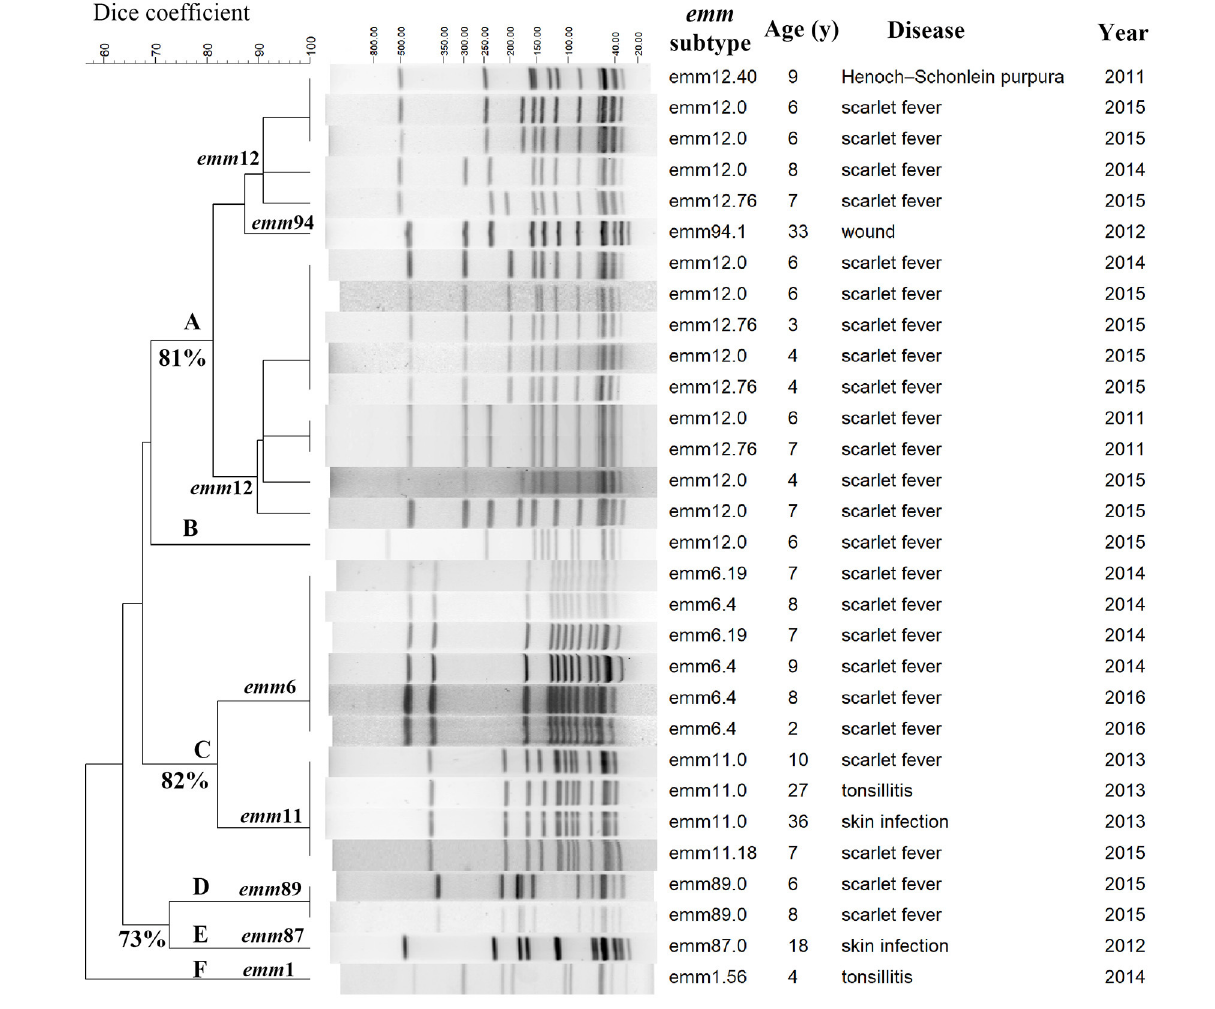
FIGURE 2 | PFGE patterns of 30 fluoroquinolone-non-susceptible S. pyogenes strains isolated between 2011 to 2016 in Shanghai, China. Clusters A-F were assigned according to 80% similarity, and, isolates with indistinguishable pulsed-field gel electrophoresis (PFGE) pattern (no different bands) were assigned to the same clone. The numbers of similarity are labeled next to the